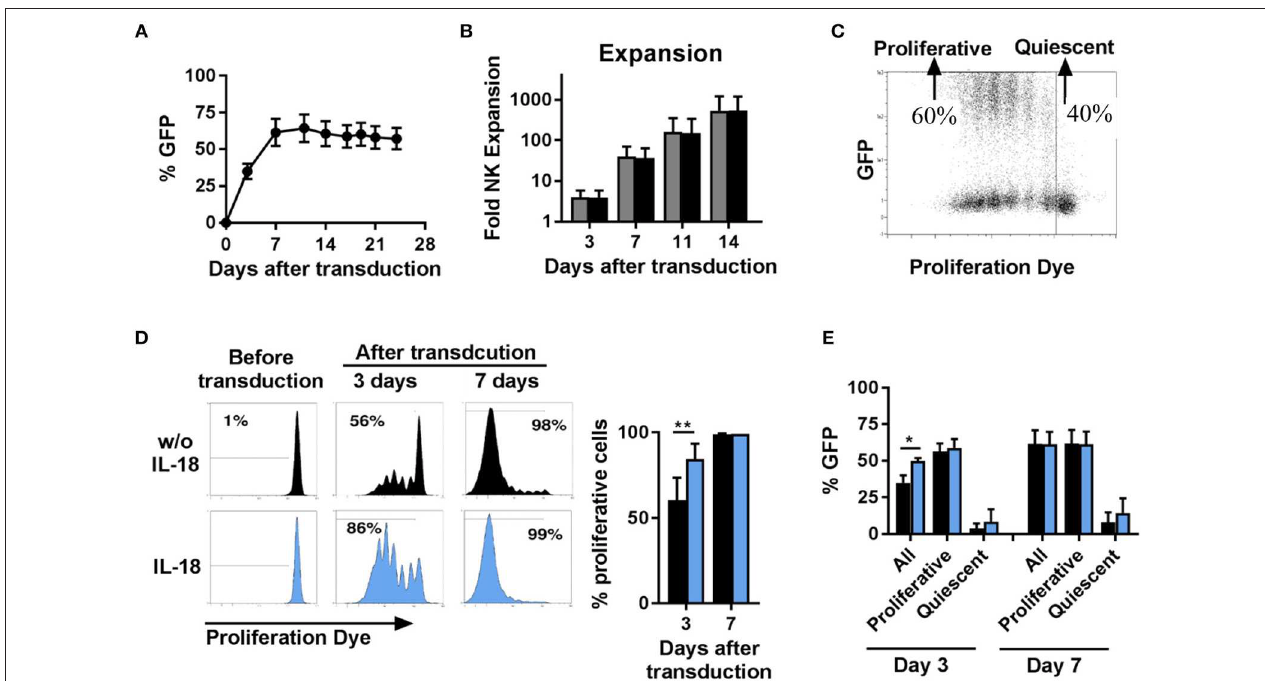
FIGURE 3 | Proliferative but not quiescent NK cells are transducible. Activated NK cells were transduced with BaEV-LV containing GFP, or the cells were left non-transduced as a control. After transduction, the kinetics of GFP expression were monitored by flow cytometry, MFI ± SD for four different donors are shown (A) . Expansion of transduced (black) and non-transduced (gray) NK cells was determined, MFI ± SD for four different donors (B) . Distribution of GFP expression among proliferative and quiescent NK cells was investigated by labeling with CellTrace Violet Proliferation Dye, an exemplary dot plot is shown (C) . Before transduction, NK cells were activated for 2 days without (black) or with IL-18 (blue). The frequency of proliferative NK cells was analyzed 3 and 7 days after transduction, exemplary histograms for 1 donor ( D left) and mean and SD for 4 donors ( D right) are shown. The frequency of GFP expressing cells among all NK cells, among proliferative NK cells and among quiescent NK cells was determined at day 3 and day 7 after transduction (E) . * P ≤ 0.05, ** P ≤ 0.005. Blue, NK cells culture in medium containing IL-18; black, NK cells culture in medium without